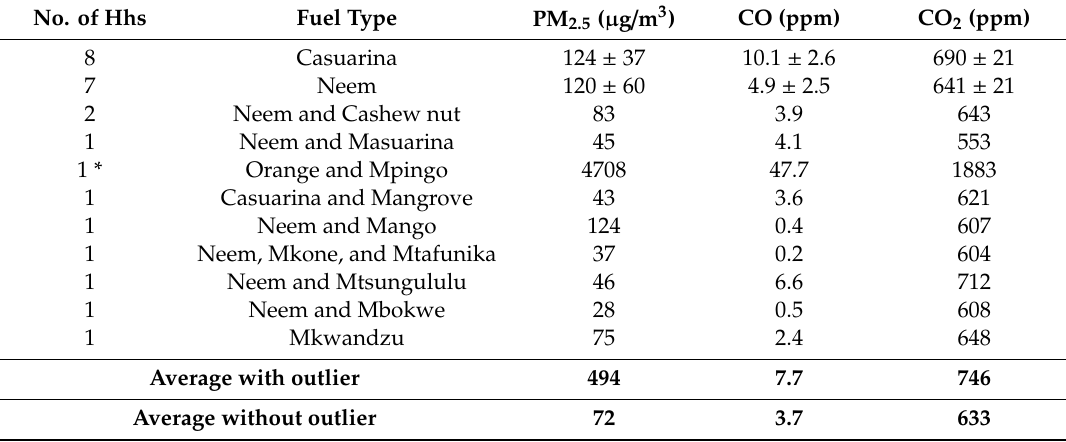
Table 4. Concentration levels of CO, CO 2 , and PM 2.5 and fuel used in cooking with gasifier. No. of